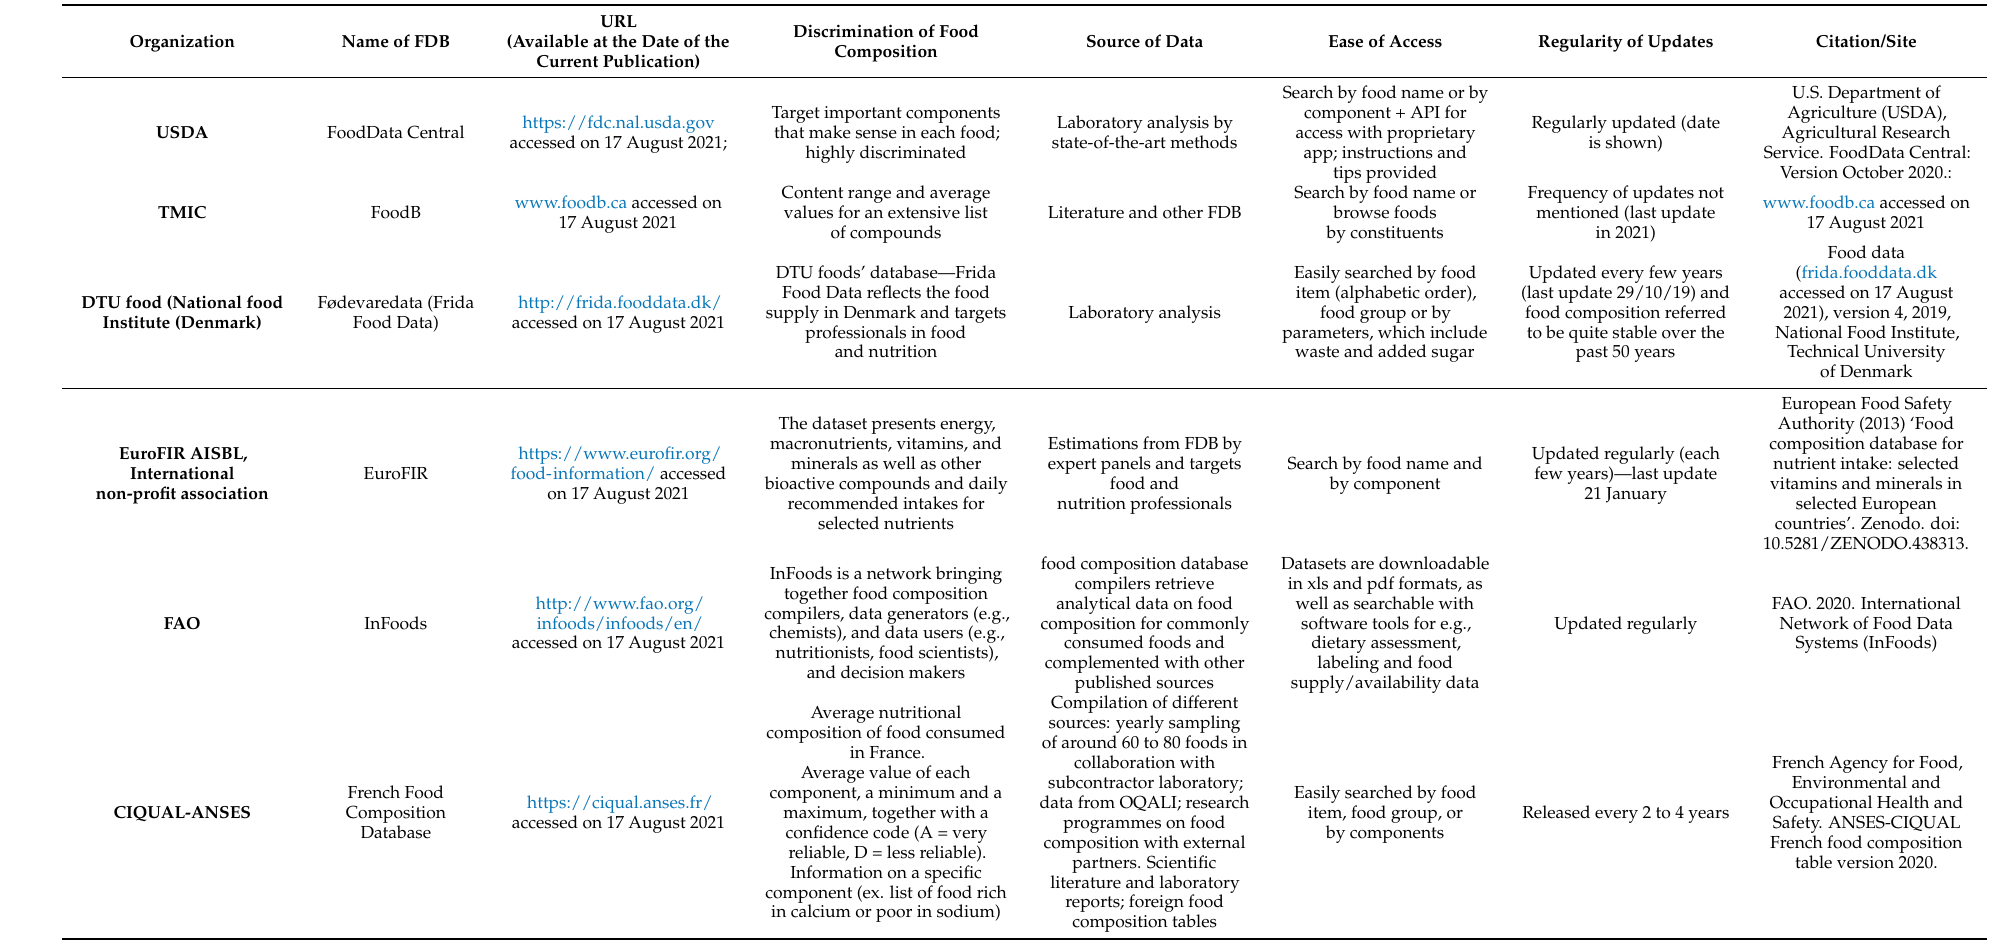
Table 1. Food composition databases publicly available, in English, allowing data searches and/or